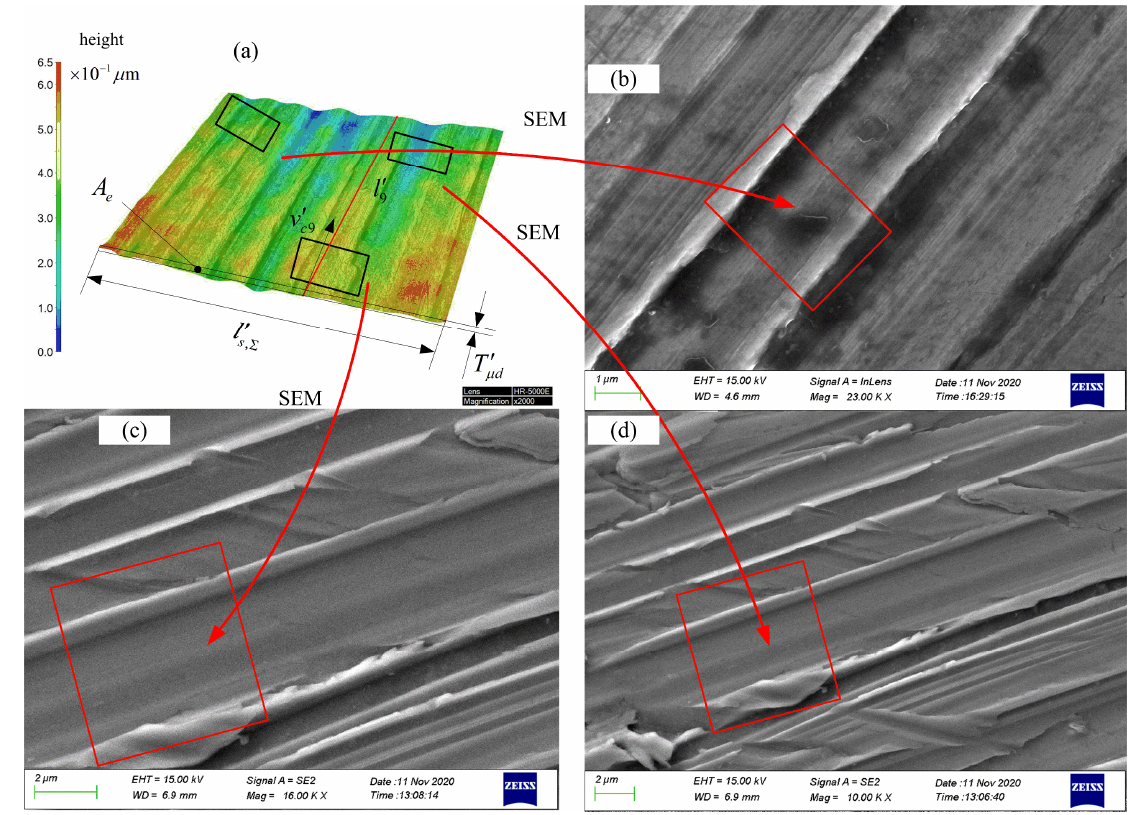
Figure 4. Partial enlargement of experimental results. ( a ) Local enlarged view of Figure 3b; ( b–d ) Local enlarged views of ( a ).